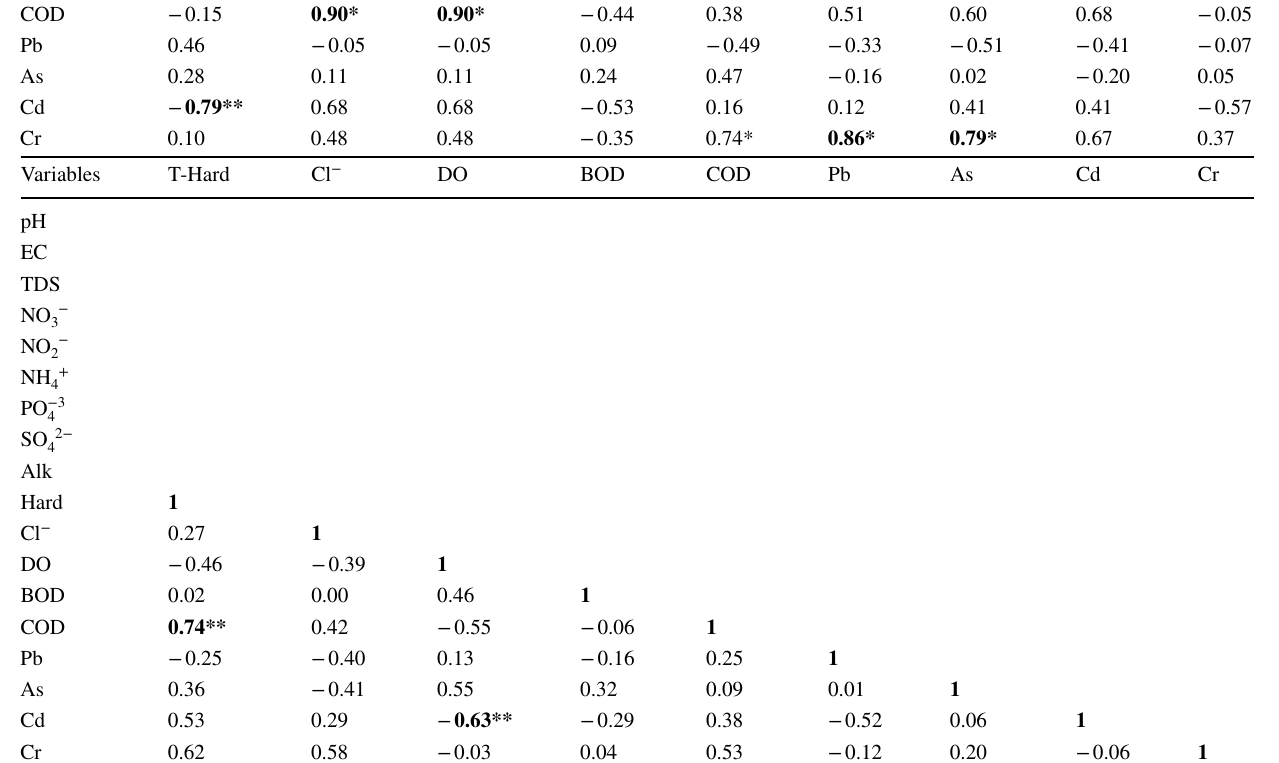
Bold characters signify the highest degree of correlation of the variables with